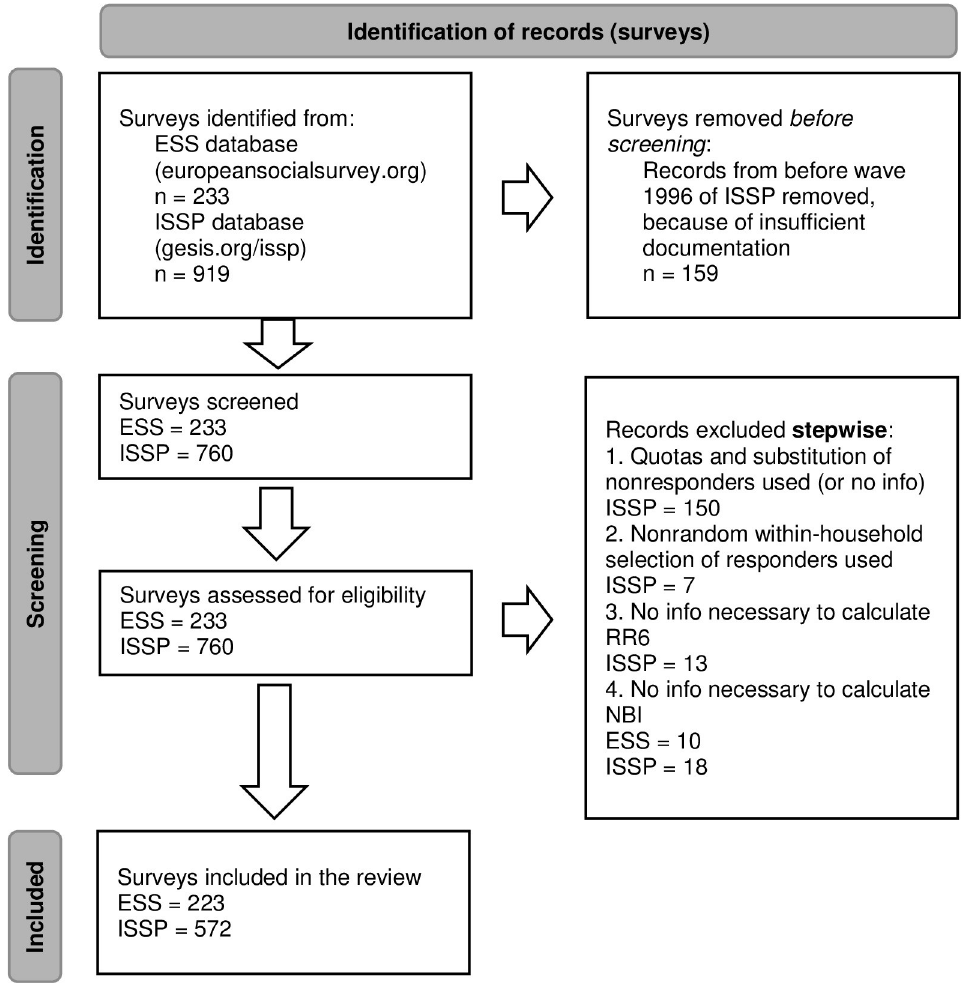
Fig 1. PRISMA flow diagram. From